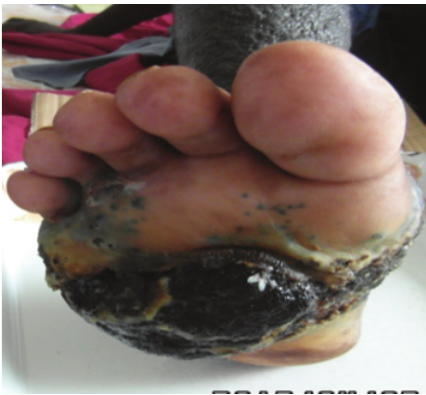
Figure 1: Nodular melanoma of the sole of the right foot.